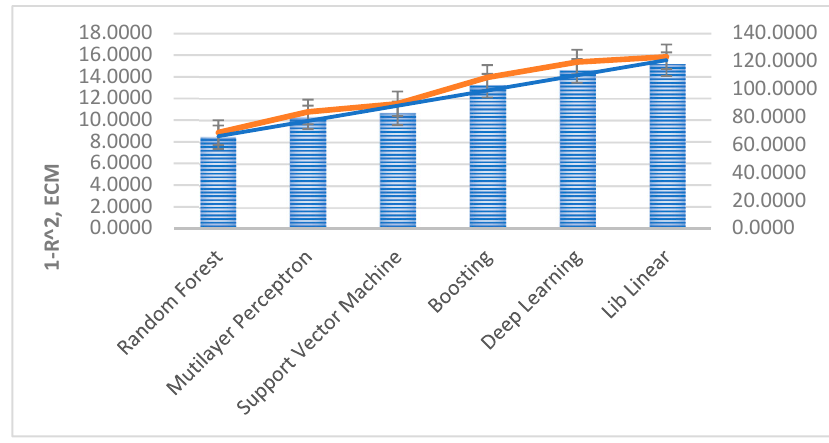
Figure 5. Graphical comparison of the different techniques results. Energies 2019 , 12 , x FOR PEER REVIEW